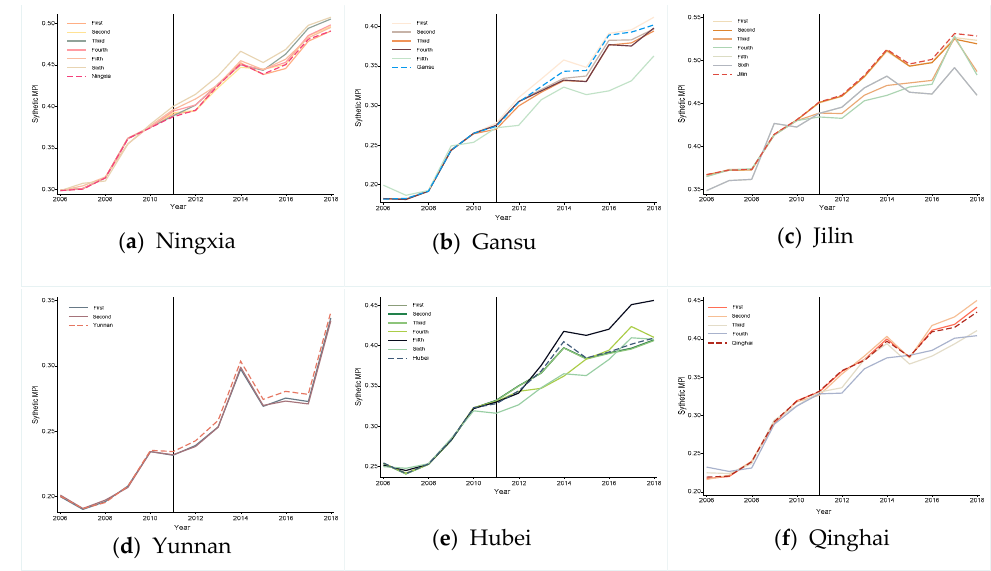
Figure 6. Comparison of MPI development tracks after removing donor groups in successive itera- tions.